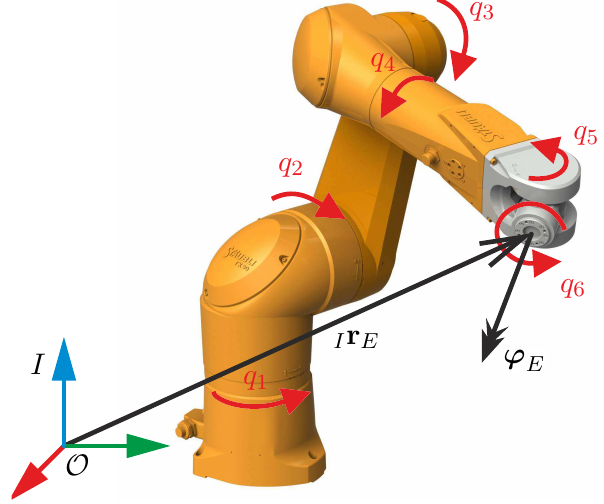
Figure 1. Arm coordinates of the Stäubli